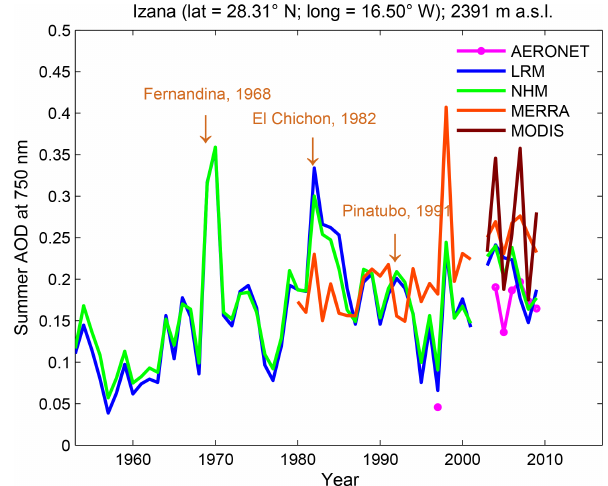
Figure 9. Scatterplot between SDF and AOD for Málaga, Spain. The regression line from LRM is the dashed line. NHM estimates are shown as green triangles.